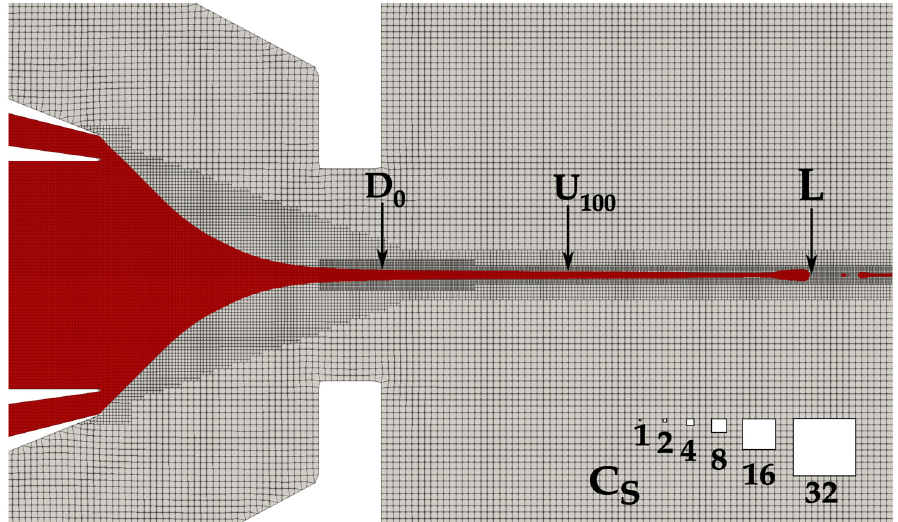
Figure 2 . Representation of the utilized mesh along with the three characteristic jets parameters: diameter, velocity and length. White boxes show the normalized cell sizes. The image is zoomed- in to show only the most interesting details.